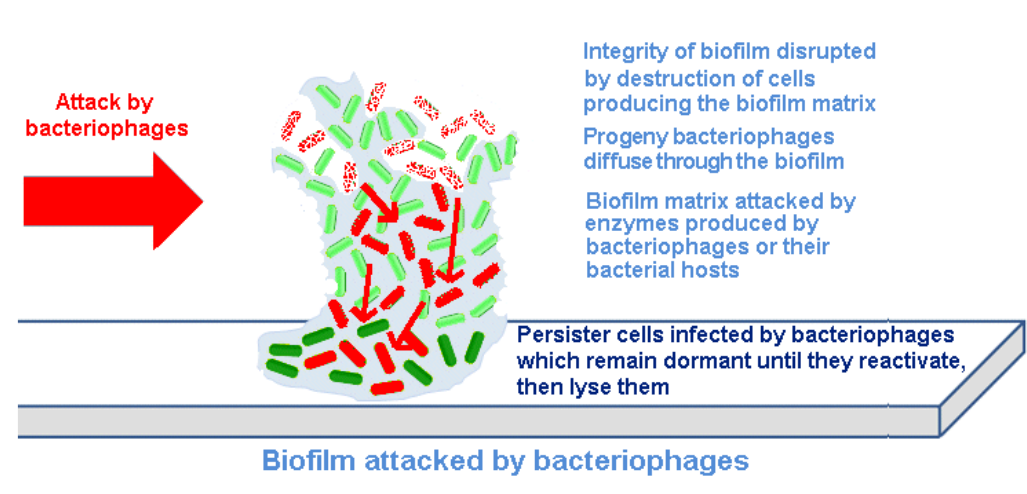
Figure 2. Destruction of a biofilm by